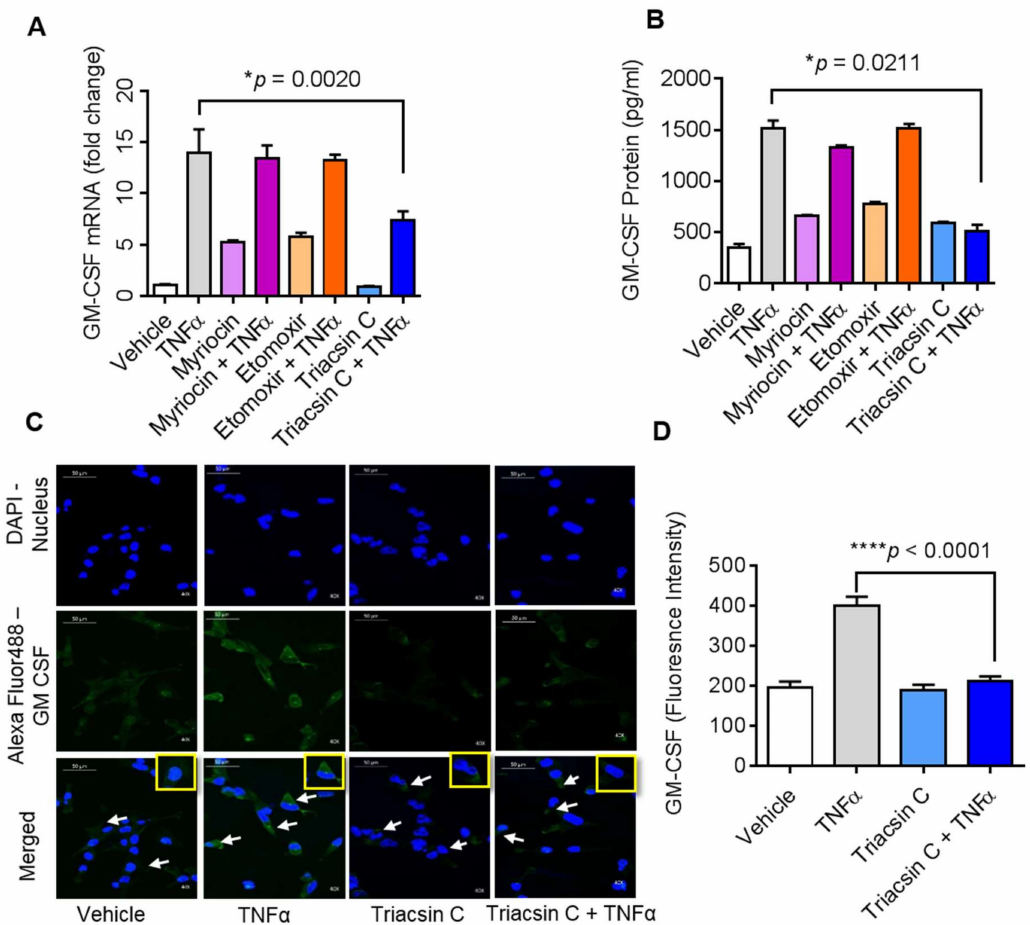
Figure 2. E ff ect of acyl-CoA synthetase 1 (ACSL1) inhibition on GM-CSF production in MDA-MB-231 cells. MDA-MB-231 cells were pretreated with a long-chain ACSL1 inhibitor (triacsin C, 5 µ M), a serine palmitoyltransferase inhibitor (SPT-1) involved in sphingolipid biosynthesis (myriocin, 1 µ M), a carnitine palmitoyltransferase 1 (CPT-1) inhibitor (etomoxir, 10 µ M), or vehicle for 1 h and then incubated with TNF α for 24 h. ( A ) GM-CSF mRNA was determined by real-time PCR. ( B ) Secreted GM-CSF in culture media was determined by ELISA. ( C ) MDA-MB-231 cells were stained with GM-CSF (green) and DAPI (blue). White arrows indicate typical stained cells. ( D ) GM-CSF fluorescence intensity was determined. All data are expressed as mean ± SEM ( n ≥ 3). * p < 0.05, **** p < 0.001 versus